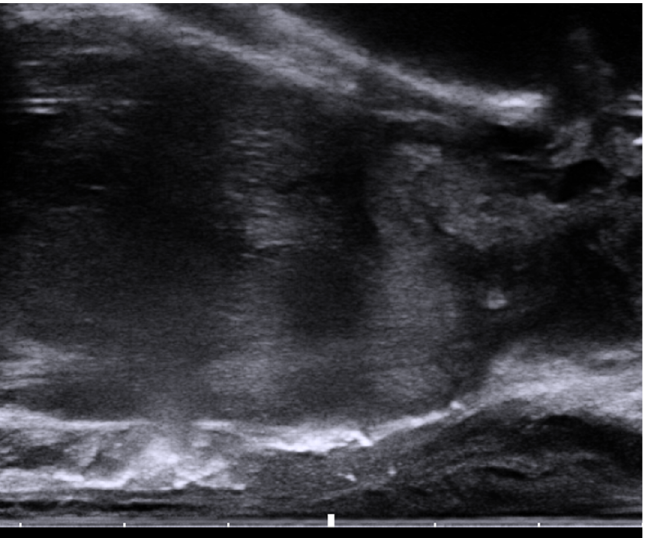
Figure 2. Sagittal view of the transrectal probe shows an echogenic spacer between the rectum and prostate.